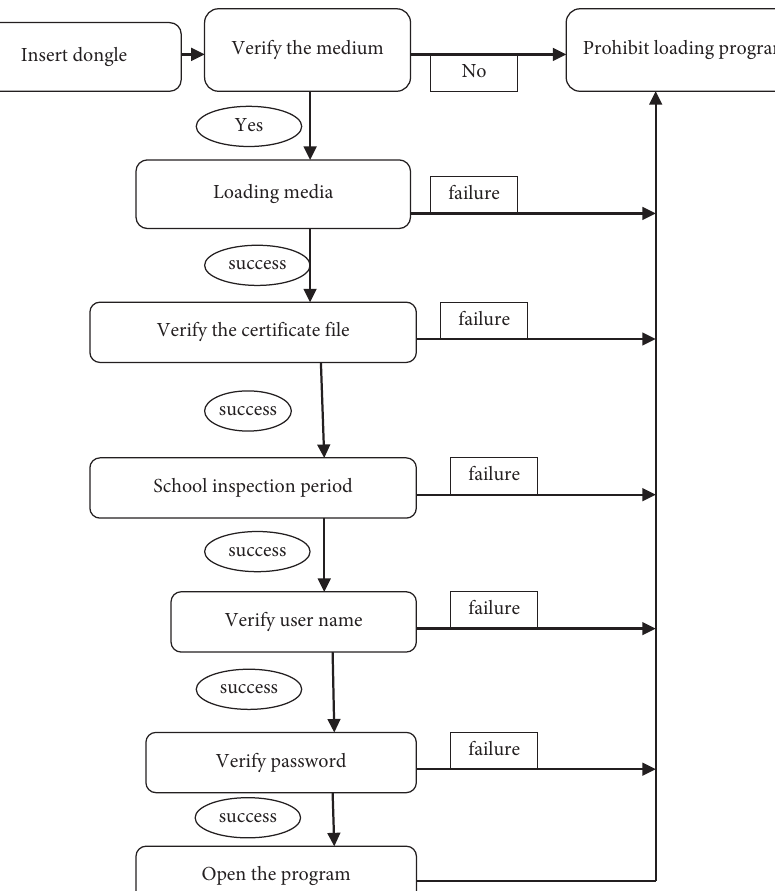
Figure 2: Operation flowchart of login authority verification